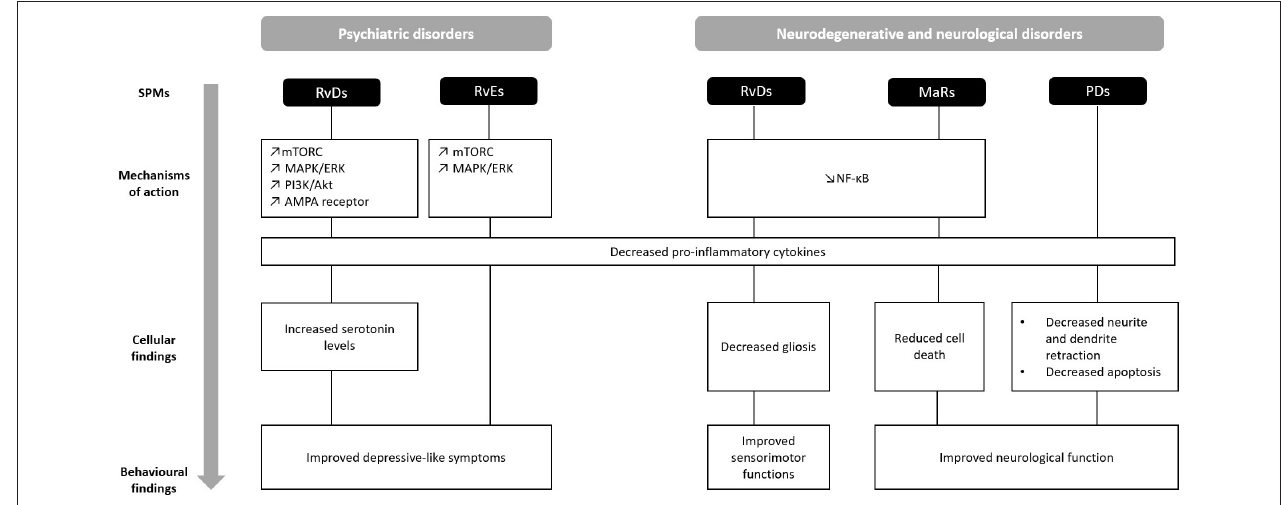
FIGURE 2 | Comparison of behavioral, cellular, and molecular findings upon treatment with SPMs in the context of psychiatric, neurodegenerative, and neurological disorders. AMPA, α -amino-3-hydroxy-5-methyl-4-isoxazolepropionic acid; MAP/ERK, mitogen-activated protein kinases/extracellular signal-regulated kinases; MaR, maresin; mTORC, mammalian target of rapamycin complex; NF- κ B, Nuclear factor-kappa B; PD, protectin; PI3K/Akt, Phosphoinositide 3-kinases/Protein kinase B; RvD, resolvins D series; RvE, resolvins E series. ր increase; ց